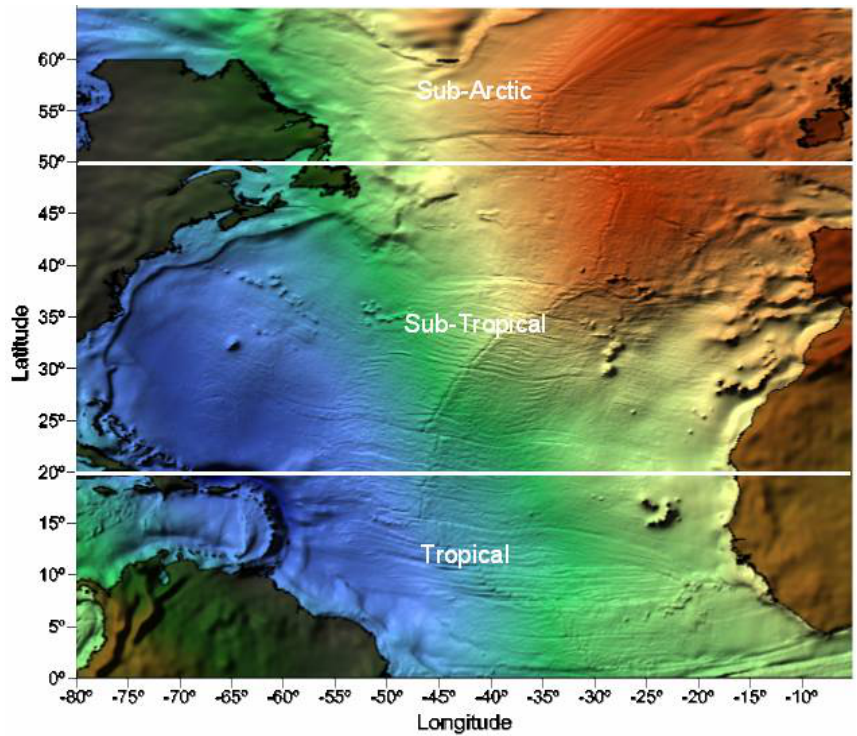
Figure 1. Study area. The background shows the GSFC00.1 mean sea